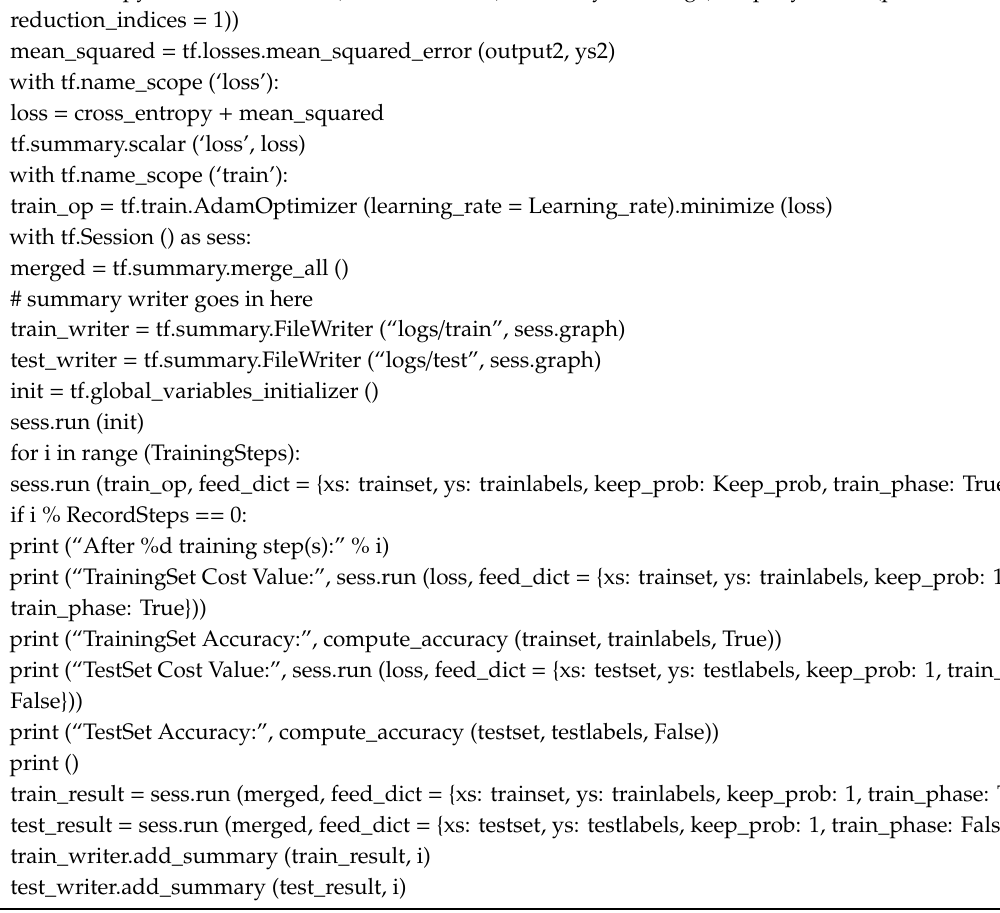
Algorithm A2. Script of cost